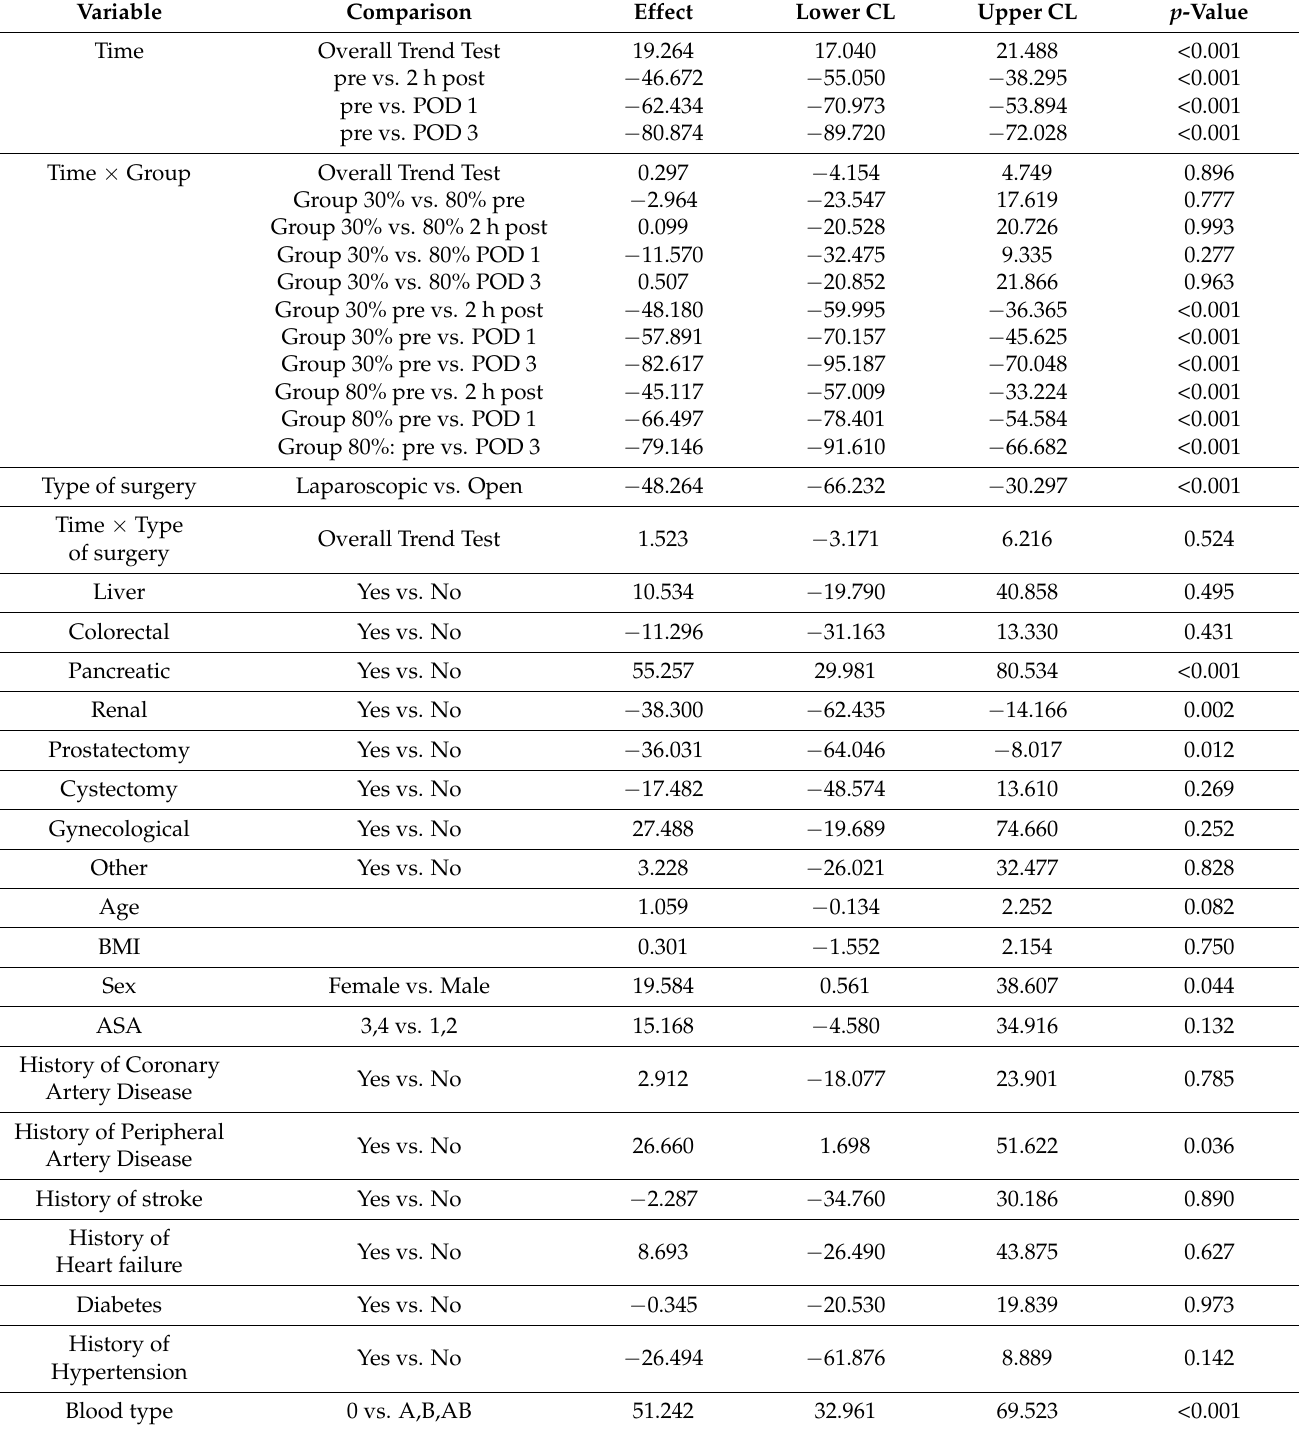
Table 2. Univariable regression models vWF. The estimated effect sizes, confidence levels (CL) and p -values were calculated using univariable regression models. pre, preoperative; 2 h post, within two hours after surgery; POD, postoperative day; BMI, body mass index; ASA, American Society of